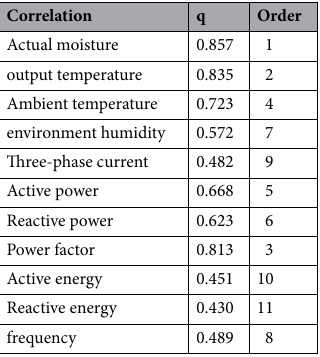
Table 1. Entropy weights of various factors on motor vibration acceleration.